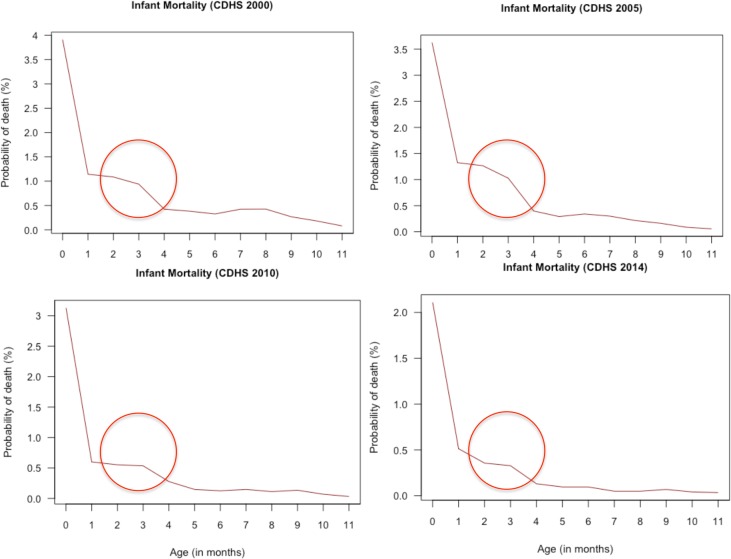
Infant mortality probability obtained from the Cambodian Demographic and Health Surveys between 2000 and 2014.The red circle highlights a peak in mortality around 3 months of age.